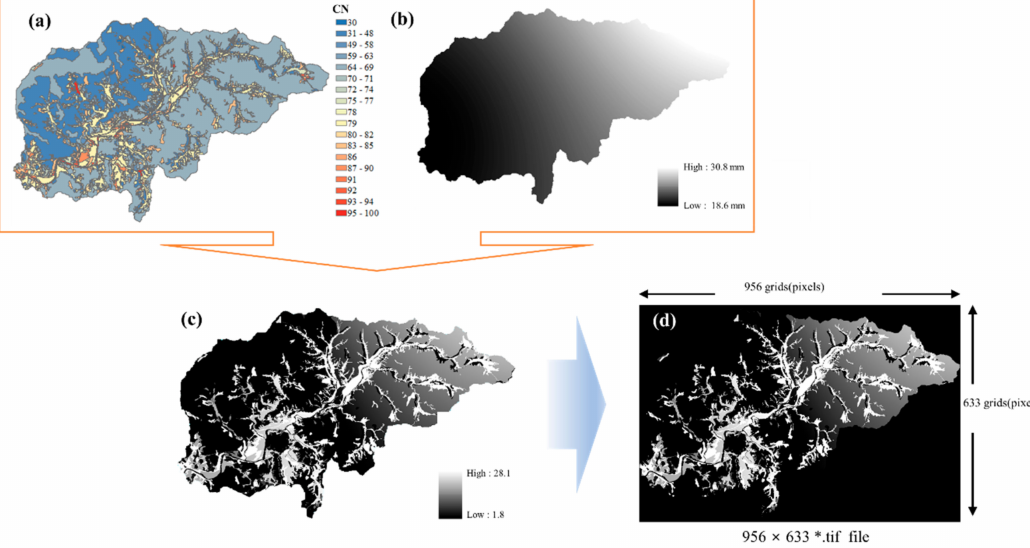
Figure 8. Example of hydrological image generation: ( a ) CN map; ( b ) precipitation map; ( c ) hydrological image; ( c ) calculation result using Equations (1)–(3); ( d ) actual hydrological image format as the model’s input